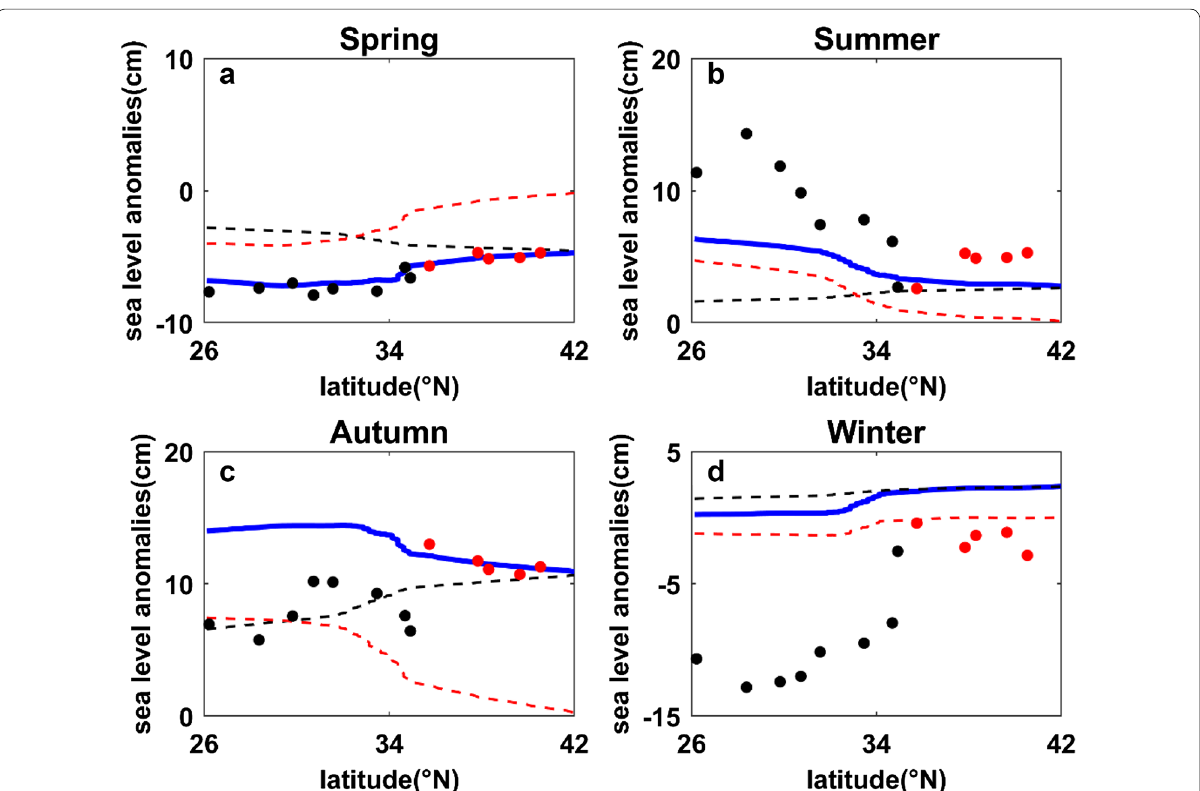
Fig. 2 Comparison of the estimated SLA 0 from Eq. 1 (blue) and the SLA from eight tide gauges (black dots) south of the KE and from five tide gauges (red dots) north of the KE in spring (March, April and May), summer (June, July, and August), autumn (September, October, and November) and winter (December, January and February). The black dash lines represent the contributions from coastal-trapped waves (the 1st term on the right-hand side of Eq. 1), while the red dash lines represent the contributions from the long Rossby waves (the 2nd term on the right side of Eq.